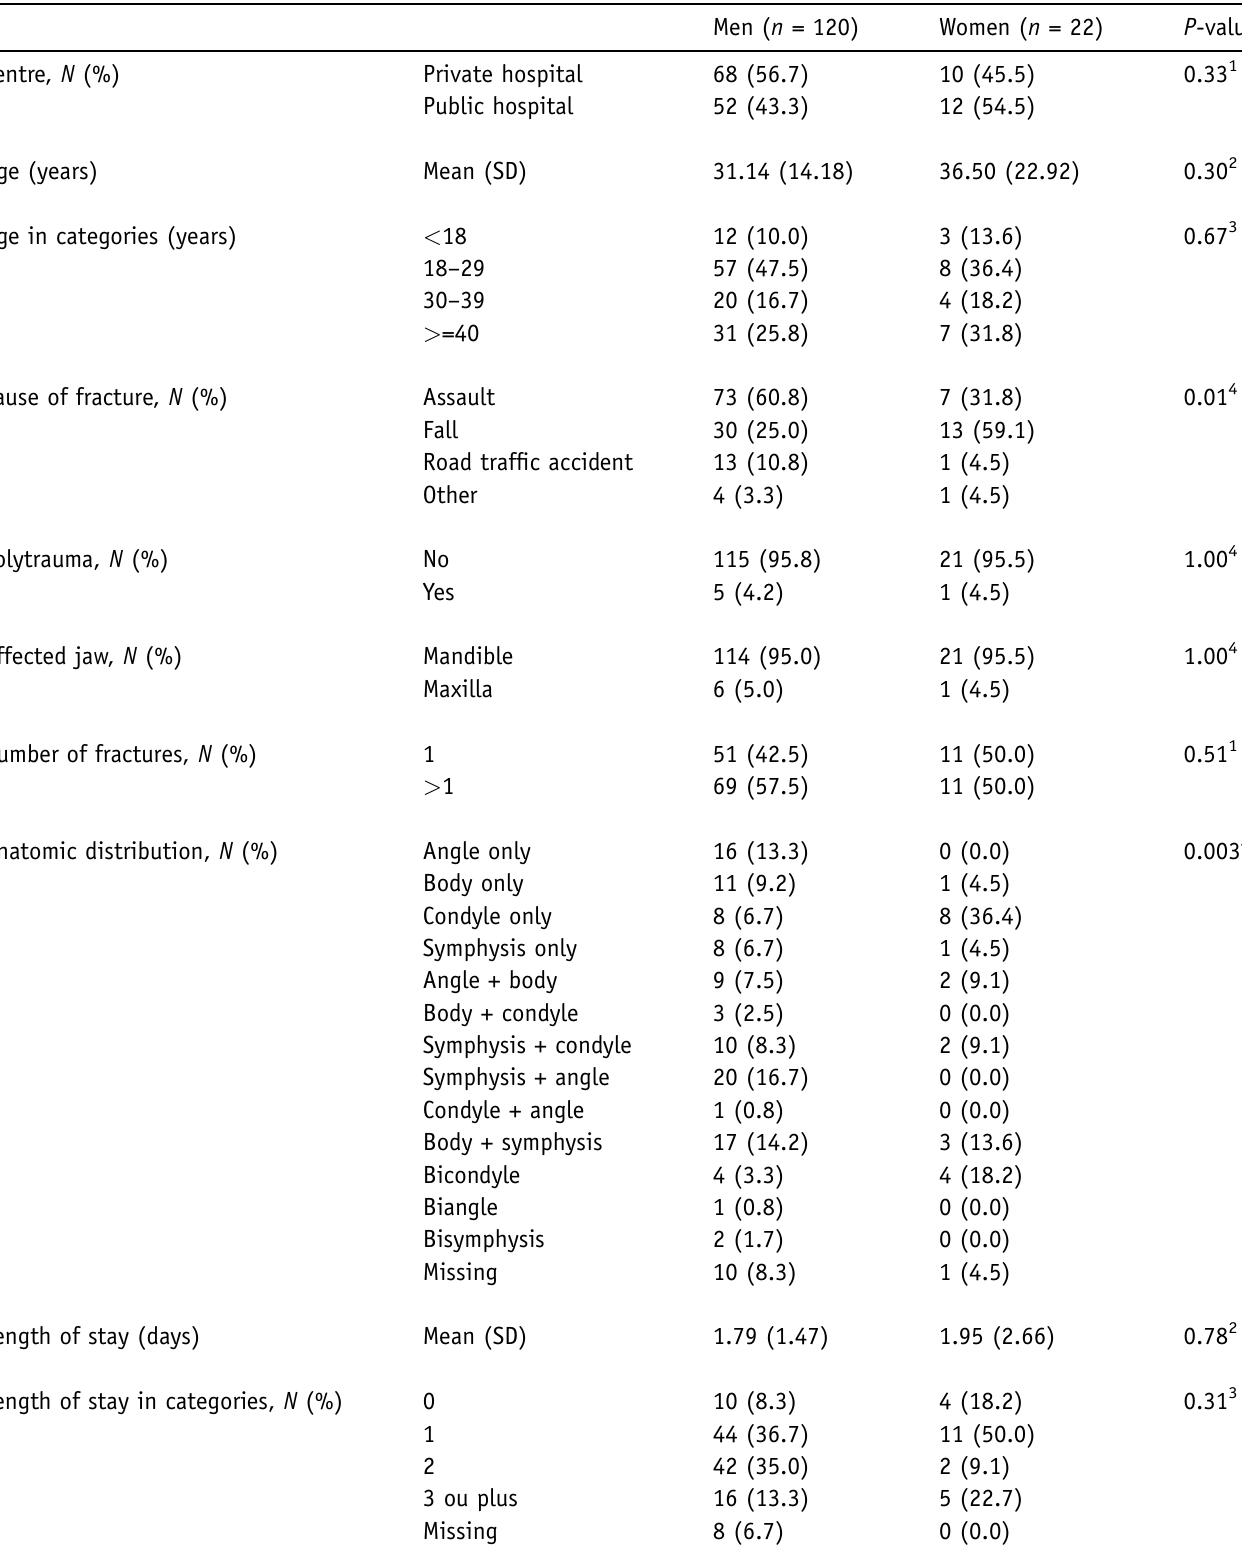
Table III. Description of patients ’ characteristics and of jaw fractures according to